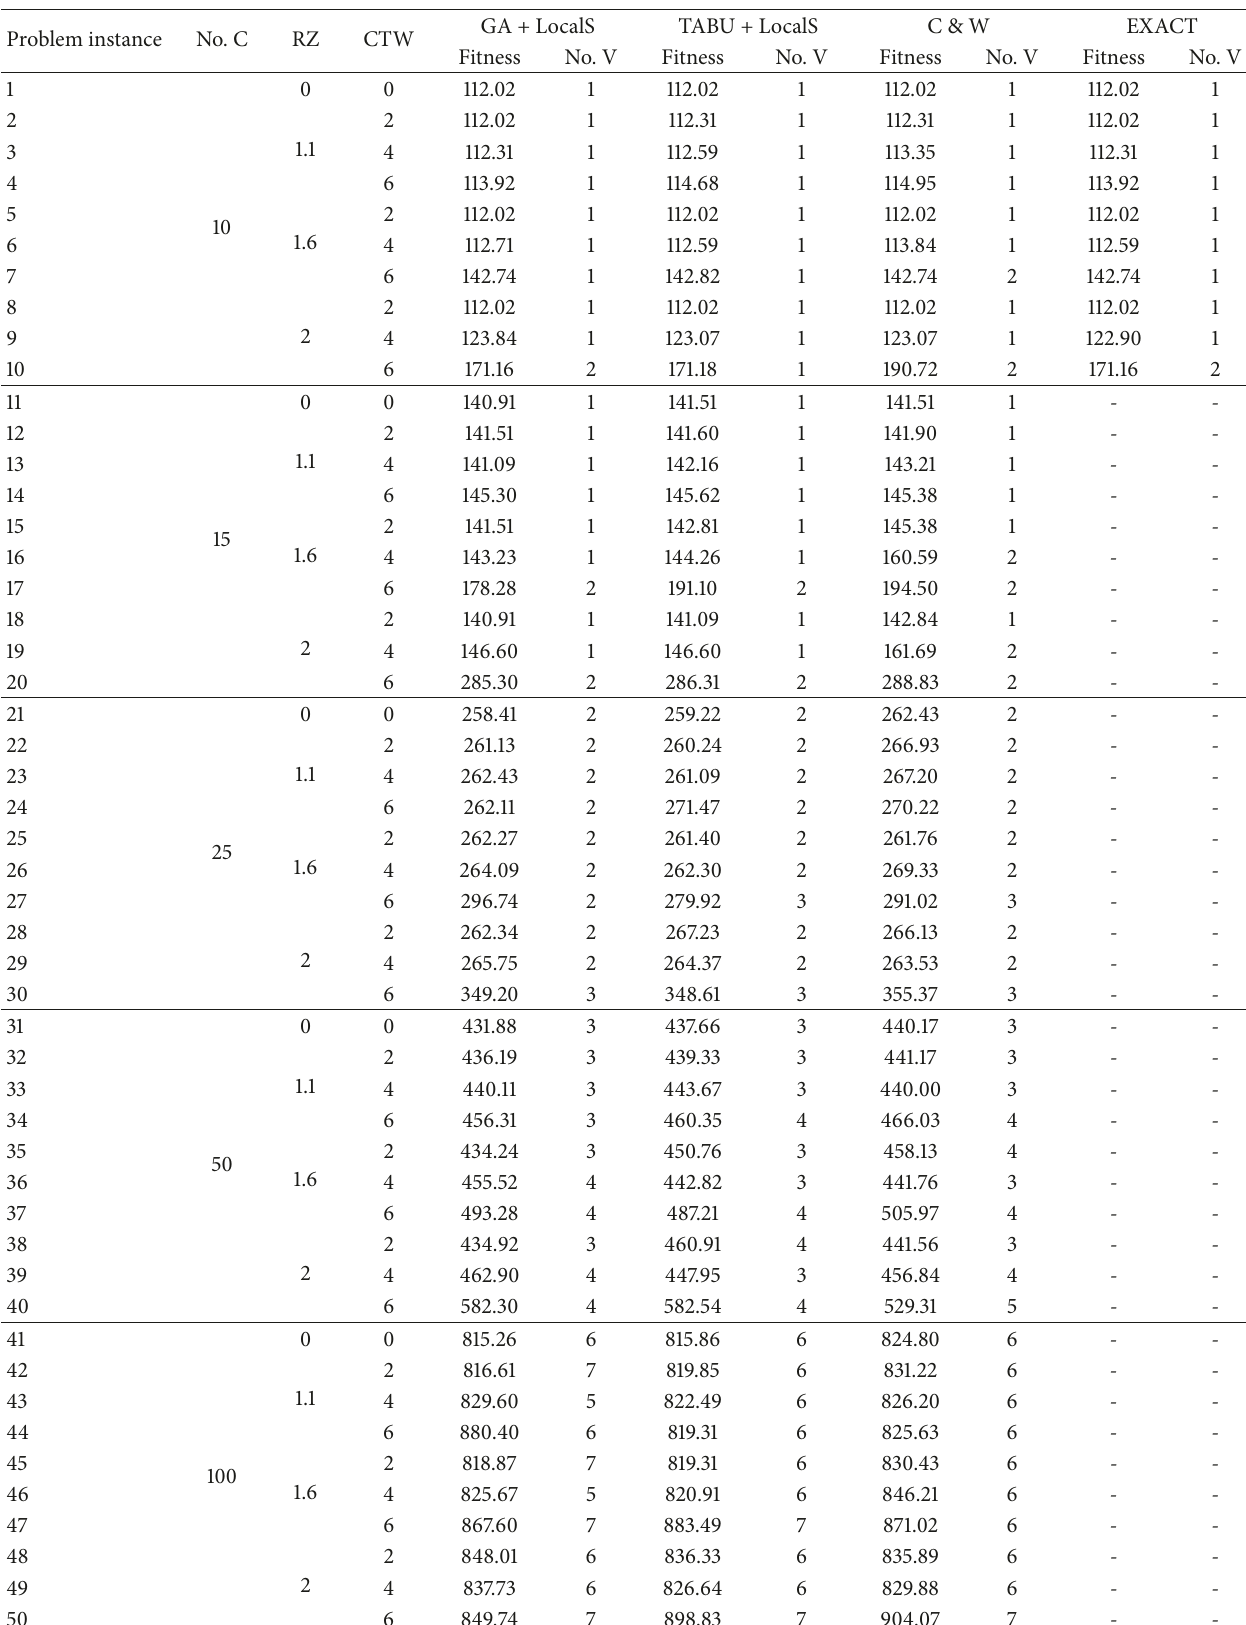
Table 1: Results obtained from the application of the different solution methodologies to 60 problem instances of the case study. For each case, the total route length (Fitness), measured in km, and the number of vehicles required (No. V) are